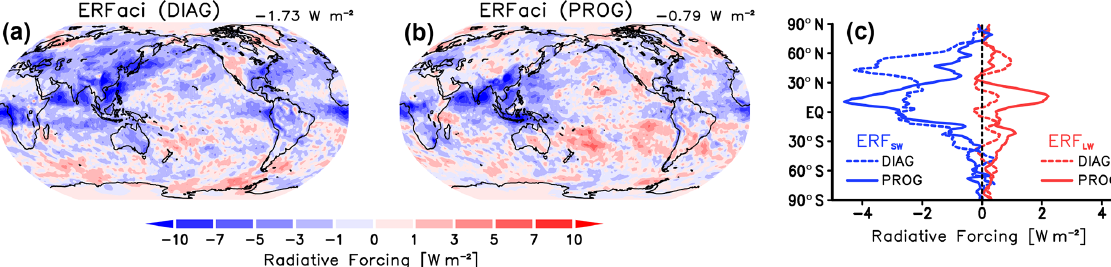
Figure 1. Geographical distribution of the annual mean clean-sky ERF aci for the (a) DIAG and (b) PROG precipitation schemes. ERF aci is decomposed into (red) longwave and (blue) shortwave components in the (c) zonal mean field for the (dashed) DIAG and (solid) PROG schemes.